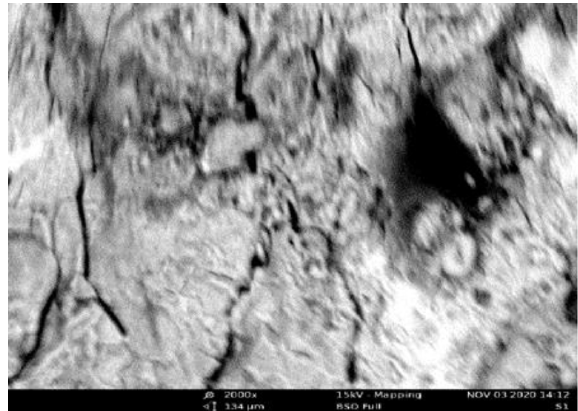
Figure 8: Plot of Inhibition eflciency (%) versus Time of inhibition (days).